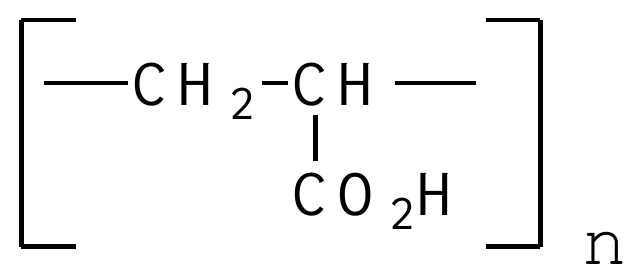
PAA Figure 1. Monomer unit of poly(acrylic acid), PAA. Figure 1. Monomer unit of poly(acrylic acid), PAA. PAA is well soluble in water, easy to handle, and available at various molecular weights. Macroscopic PAA hydrogels are stimuli-sensitive, which makes them attractive as chemical sensors, actuators, etc. [47–49]. Since we intend to generate PAA radicals by ionizing radiation, we take advantage of the fact that radiation chemistry of PAA has been previously studied in some detail [15,50–54]. Moreover, our interest in this polymer is stimulated by recent progress in synthesizing, by the radiation technique, and studying both physicochemical and application-oriented properties of nanogels based either